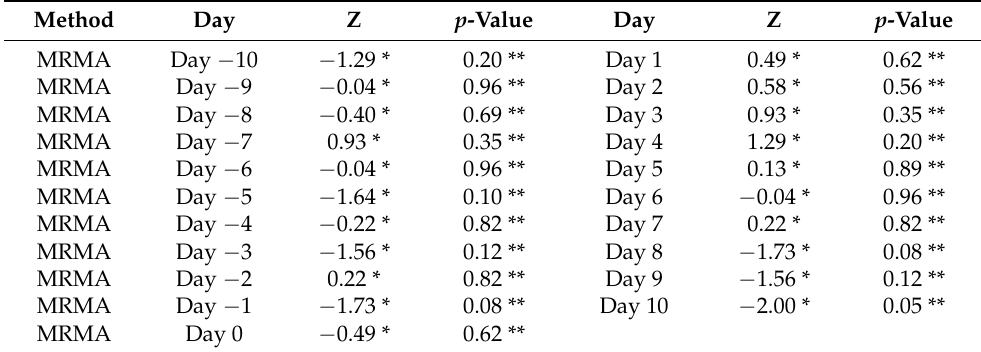
Table 5. Wilcoxon signed-rank test, MRMA method.